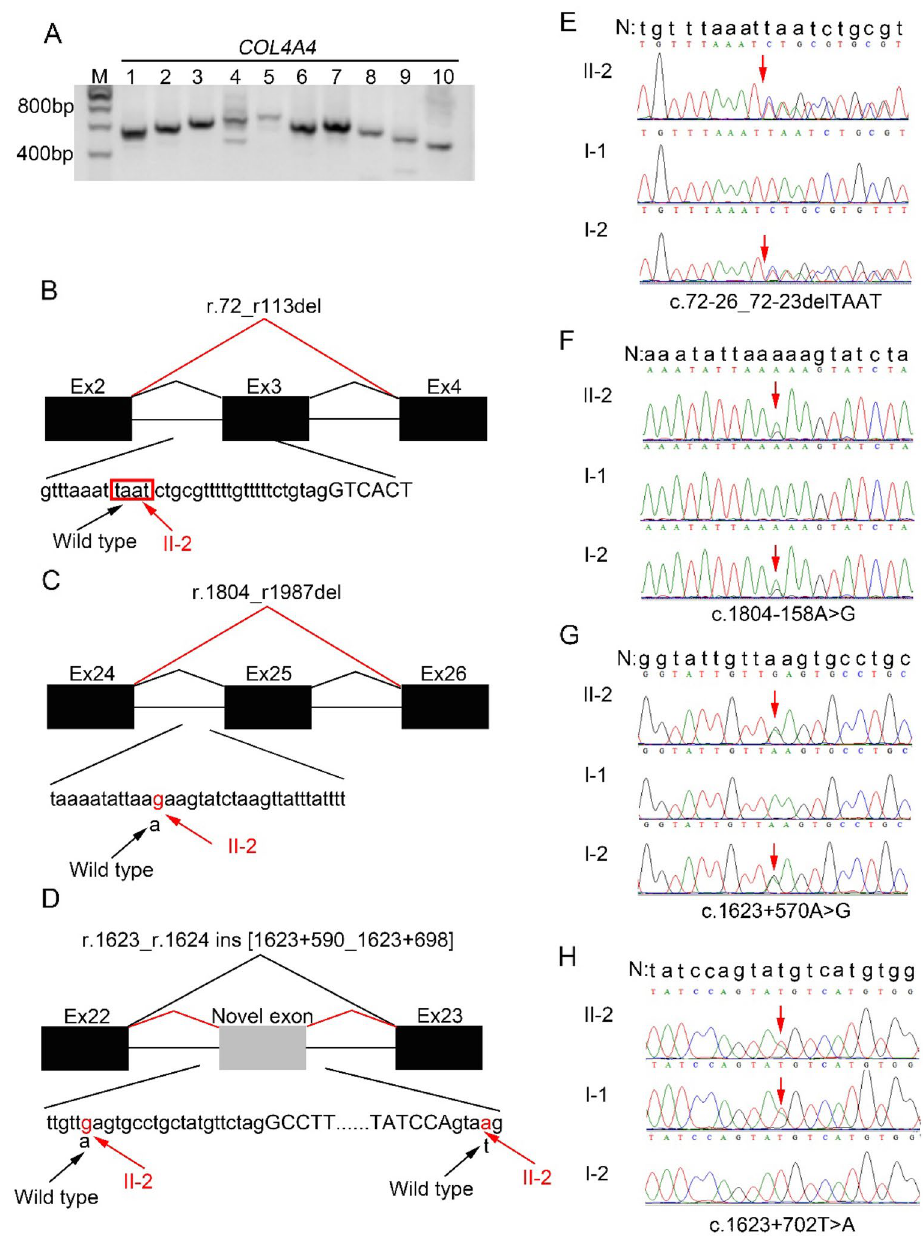
Figure 3. COL4A4 gene analysis in proband 1 (II-1 of family 1). ( A ) Agarose-gel images of RT-PCR products for proband 1 (II-1 of family 1) urine. M: DNA molecular mass marker. Lane 1 to 10: 10 overlapping PCR products covering the entire COL4A4 cDNA from proband 1 (II-1 of family 1). ( B , C , and D ) Schematic representation of the aberrant COL4A4 cDNA caused by the deep intronic splice variants detected in proband 1 (II-1 of family 1). Exons are represented by black filled rectangles and are numbered, and the novel exon is indicated by the gray filled rectangle. Capital and lowercase letters depict exon and intron sequences, respectively. The black and red lines indicate wild-type and abnormal splicing, respectively. The black arrows indicate the wild-type nucleotide(s), the red arrows show the changed nucleotides, and the red box shows the nucleotides that should have been detected in wild-type but were deleted in the proband. ( E , F , G , and H ) Sequencing of PCR amplified products containing the deep intronic variants for family 1. N, wild type sequence. Intron sequences are depicted by lowercase letters. The red arrows indicate the breakpoint and changed